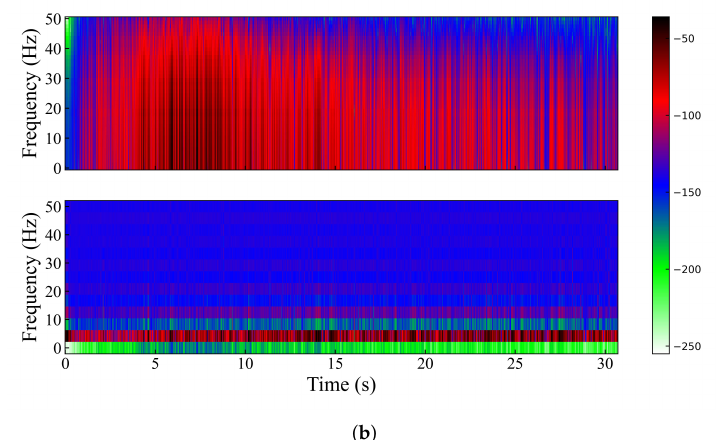
Figure 3. Duration adjustment and hand-crafted feature: ( a ) Before and after duration adjust- ment. (e.g., 1989 Loma Prieta earthquake, site Saratoga-Aloha Ave.). ( b ) Hand-crafted features: Log Mel-spectrum (top) and MFCCs (bottom).